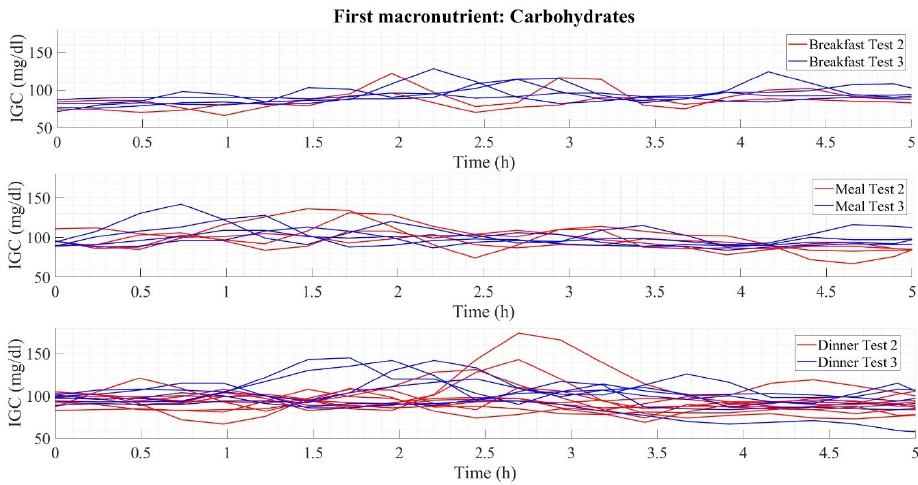
Figure 3. Glycemic variability in early carbohydrate consumption.